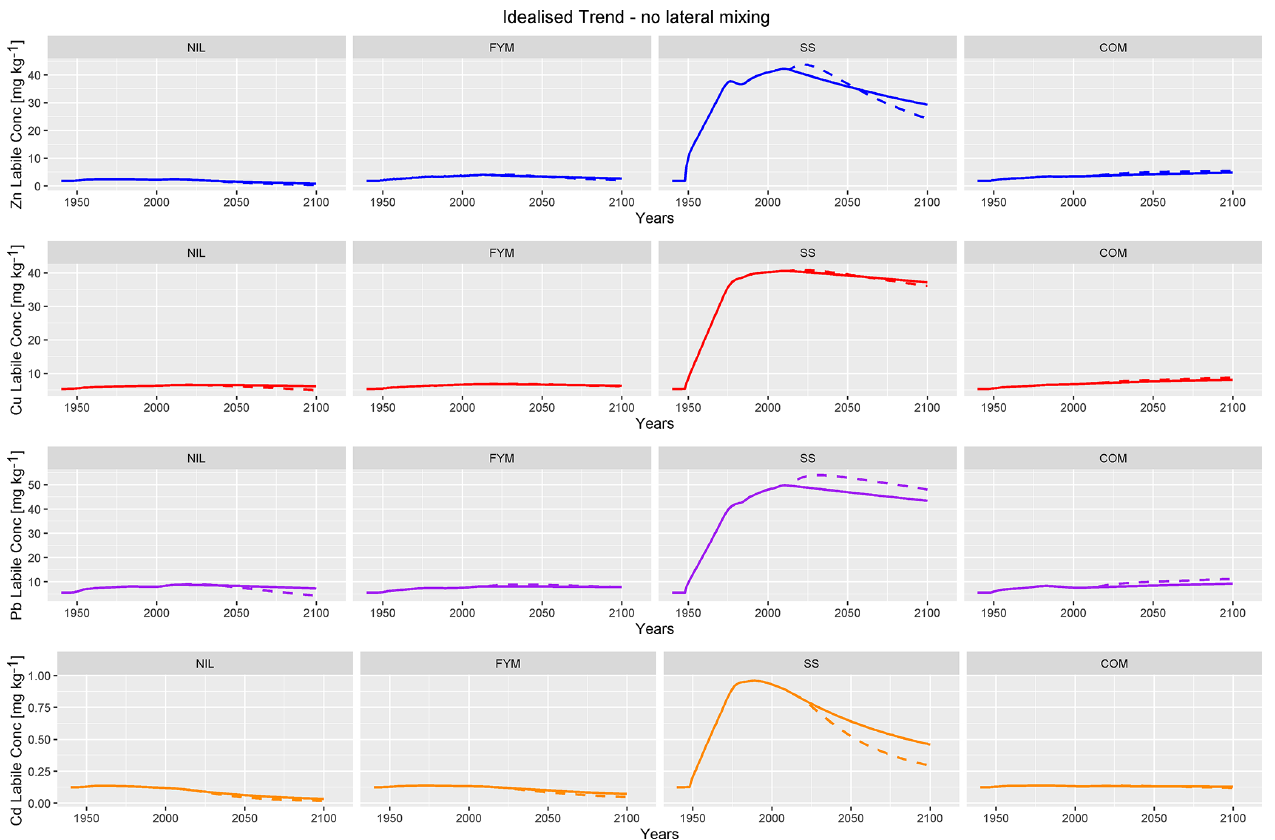
Figure 8. Projected labile concentrations for Zn, Cu, Pb and Cd to 2100 without lateral mixing and with idealised trend inputs. The following two scenarios are considered: constant pH (solid line) and pH decreasing exponentially to 0.5 units below the 2014 value (dotted